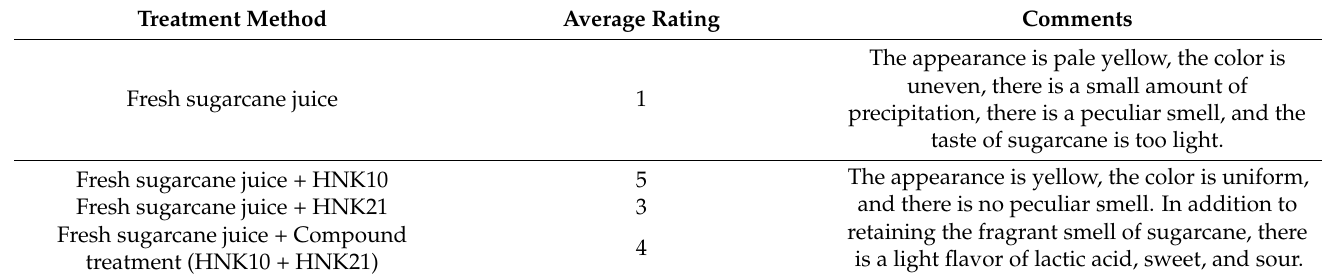
Table 4. Results of the sensory analysis. The average rating was ranked from least liked (0) to most liked